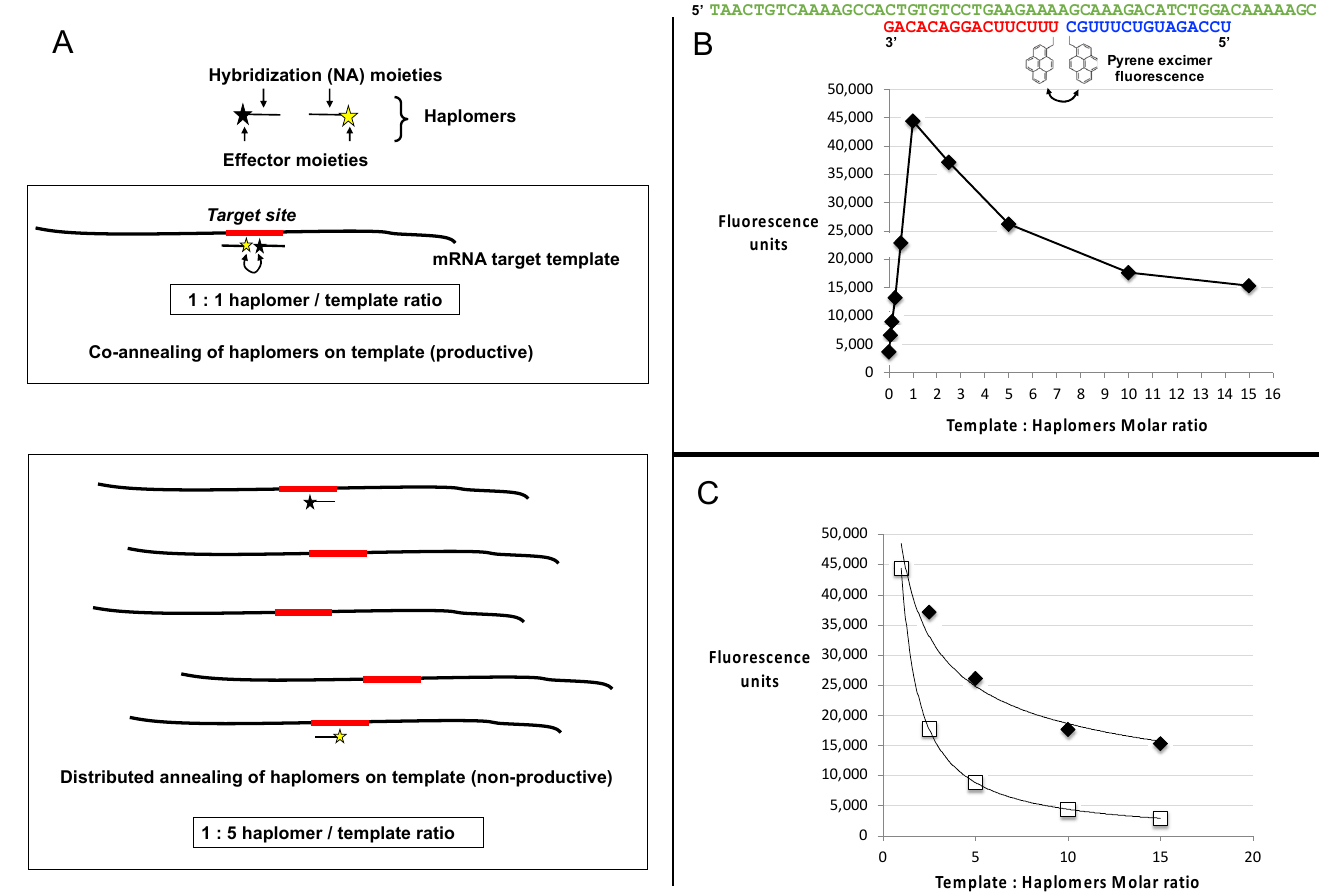
Figure 3. Template titration effects in vitro. ( A ) Schematic depiction of a binary haplomer pair and a template conforming to Architecture 2 (as shown in Figure 1C and Supplementary Figure S1B), in equimolar conditions allowing mutual hybridization and reaction to occur (1:1 hap- lomers/template ratio panel), and in conditions of template excess (1:5 haplomers/template